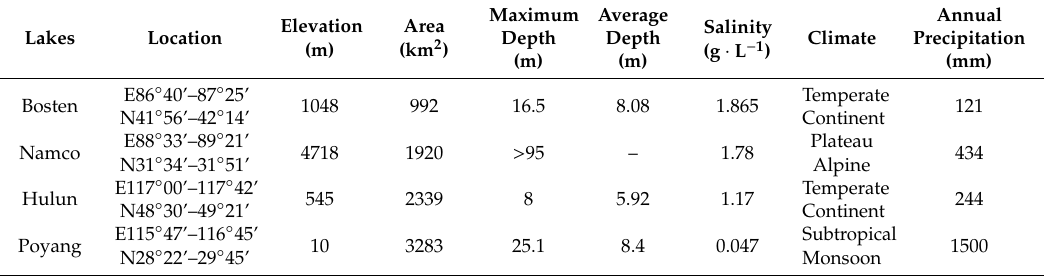
Figure 1. Location of four case study areas. Landsat true color images show the water body extent of the case study areas. Table 1. Basic details of the four lakes.